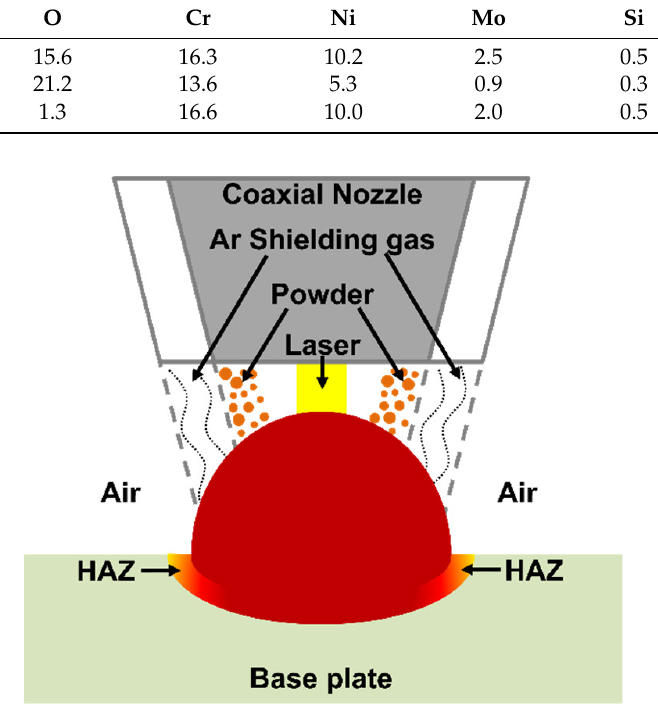
Figure 5. Secondary electron image of the top view of a printed clad in which three regions are marked from where EDX analysis was conducted: (region 1 ) on the top of the printed clad, (region 2 ) in the close vicinity of the printed clad at the HAZ, and (region 3 ) on the base plate relatively far from the printed clad. Table 2. Elemental composition calculated from the EDX spectra acquired in the regions highlighted in Figure 5.